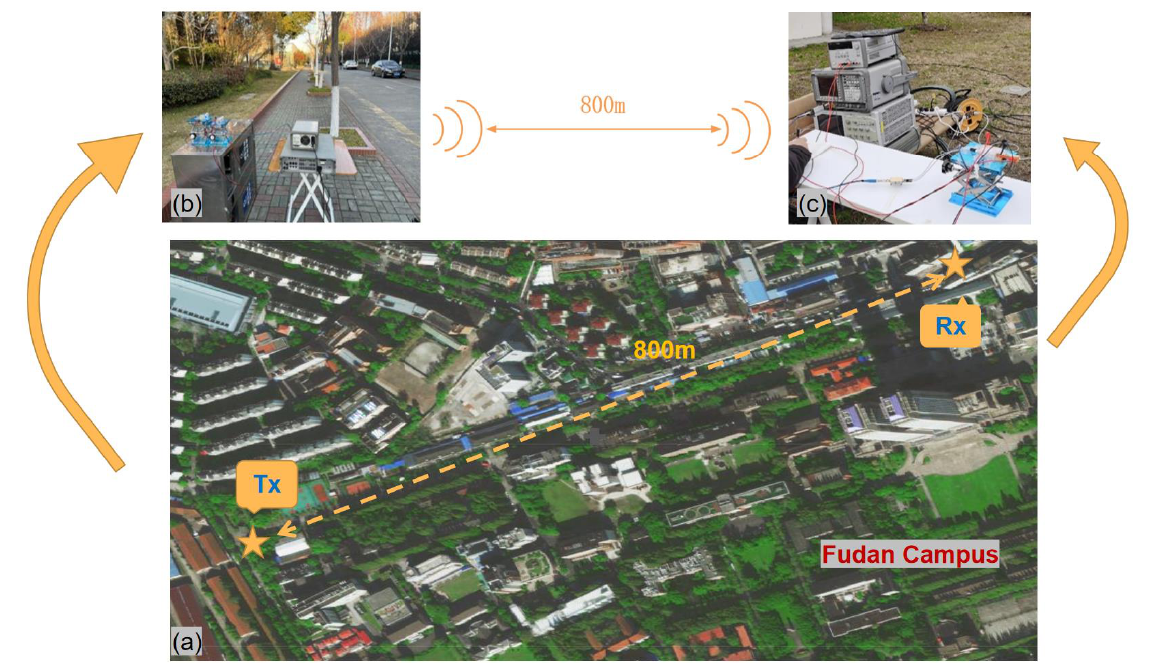
Figure 4. ( a ) Satellite map of D-band transmission 800 m wireless link on Fudan campus; ( b ) photo of Tx-side; ( c ) photo of Rx-side.